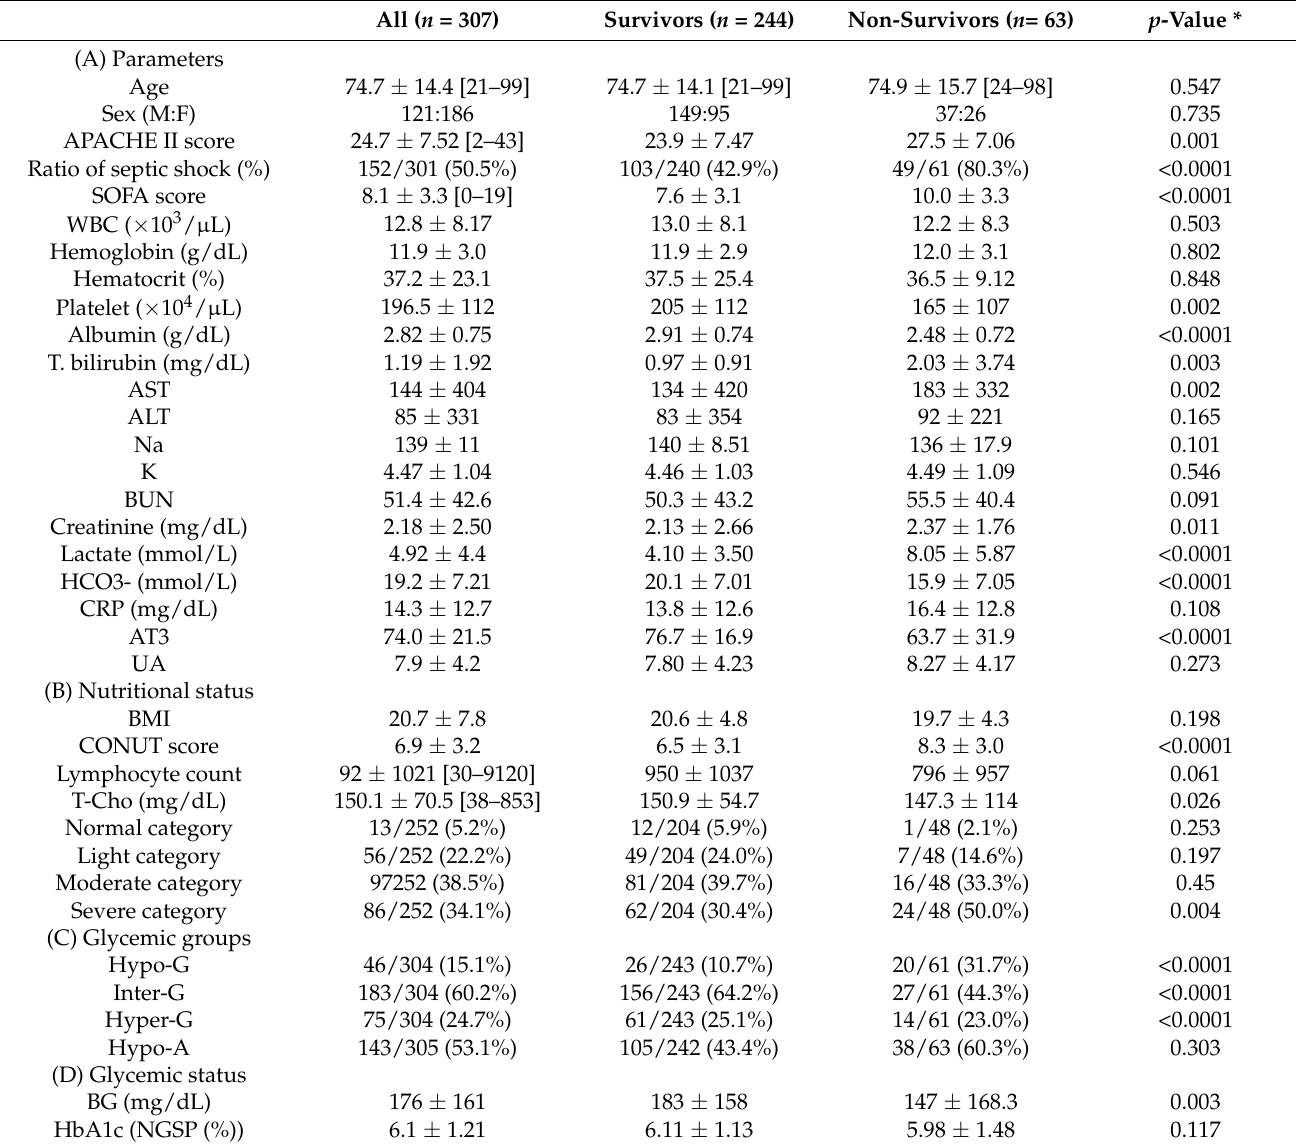
Table 1. Comparison of survivors and